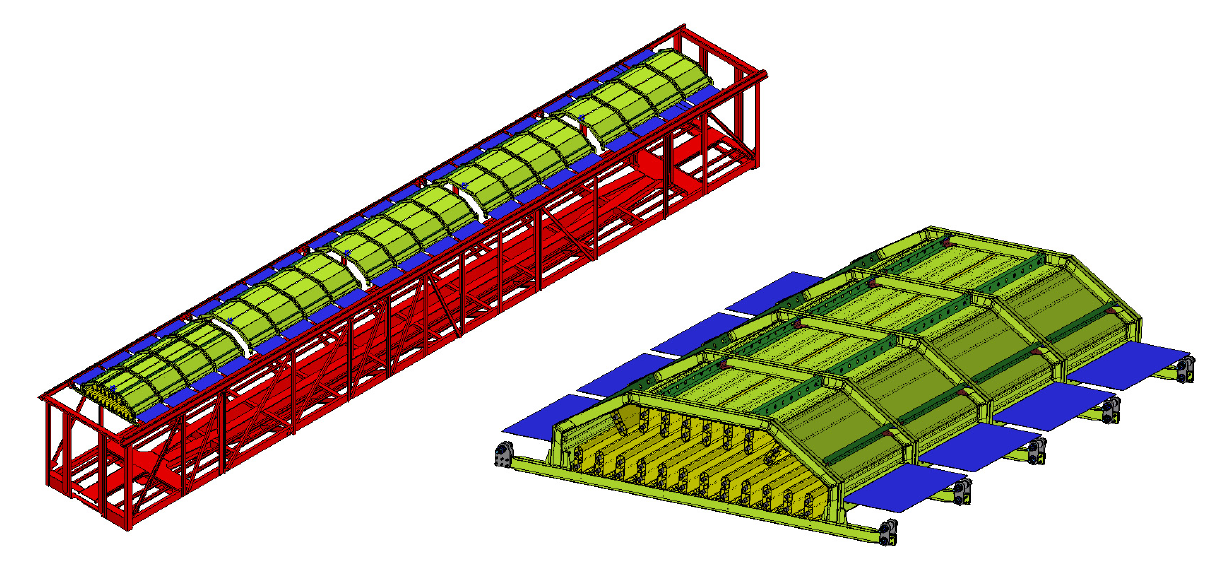
Figure 2: Structure of the roof of the freight car.